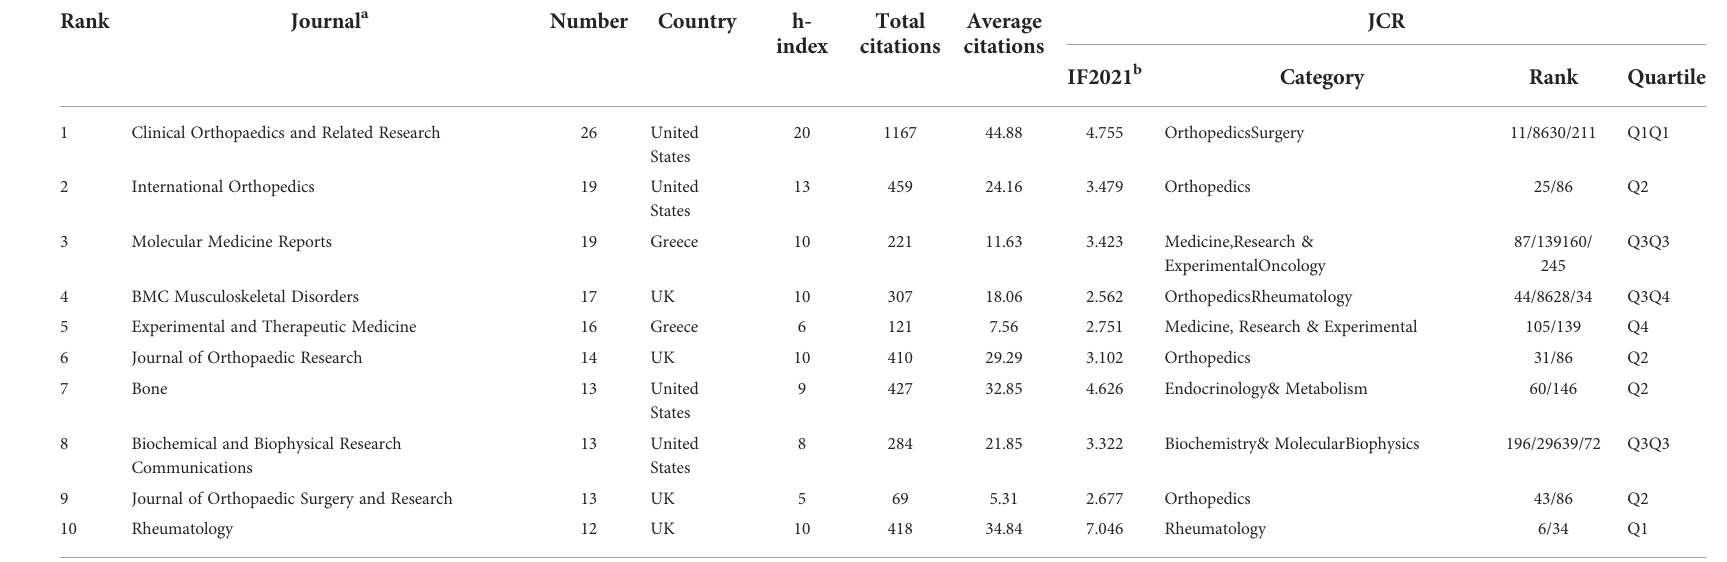
TABLE 1 Top 10 productive journals on SONFH from 1992 to